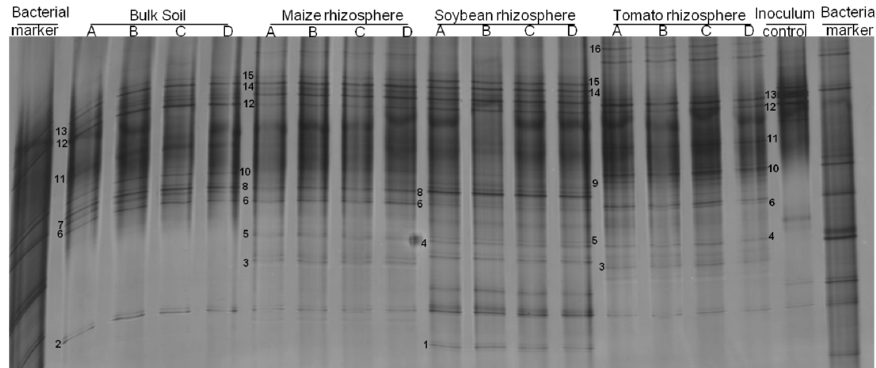
Figure 3. Denaturing gradient gelelectrophoresis (DGGE) profiles of bacterial 16S rRNA fragments amplified from DNA of Pratylenchus penetrans incubated in microbial suspensions of bulk soil and the rhizospheres of maize, soybean, and tomato plants grown in the same soil (Experiment 1). Letters A, B, C, and D represent biological replicates. Surface-sterilized nematodes prior to incubation are referred to as inoculum control. Numbers 1–15 represent bands that were taxonomically assigned by DNA sequencing and that showed specificity of bacterial species in their attachment to P. penetrans .